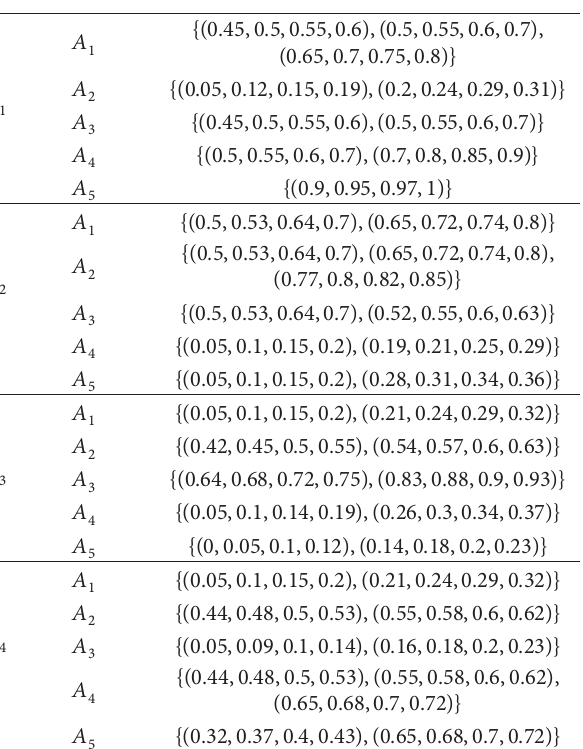
Table 1: Decision matrix ( and 3 ( 𝑒 1 , 𝑒 2 , and 𝑒 3